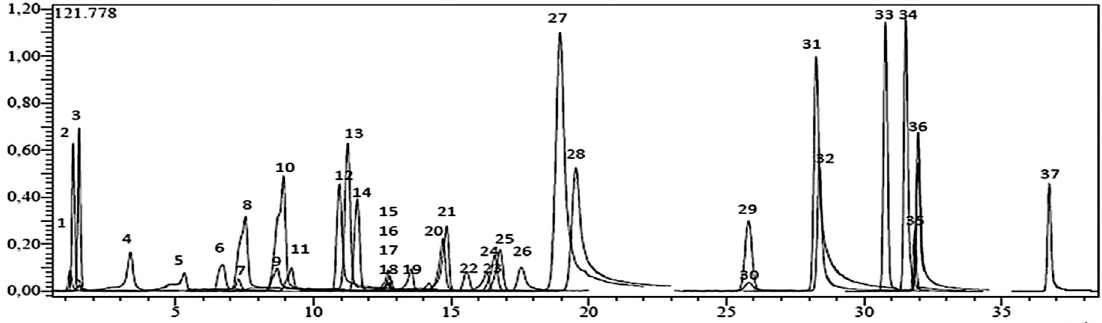
Figure 2. TIC chromatogram of the standards mixture (1 μ g/mL) analyzed by the